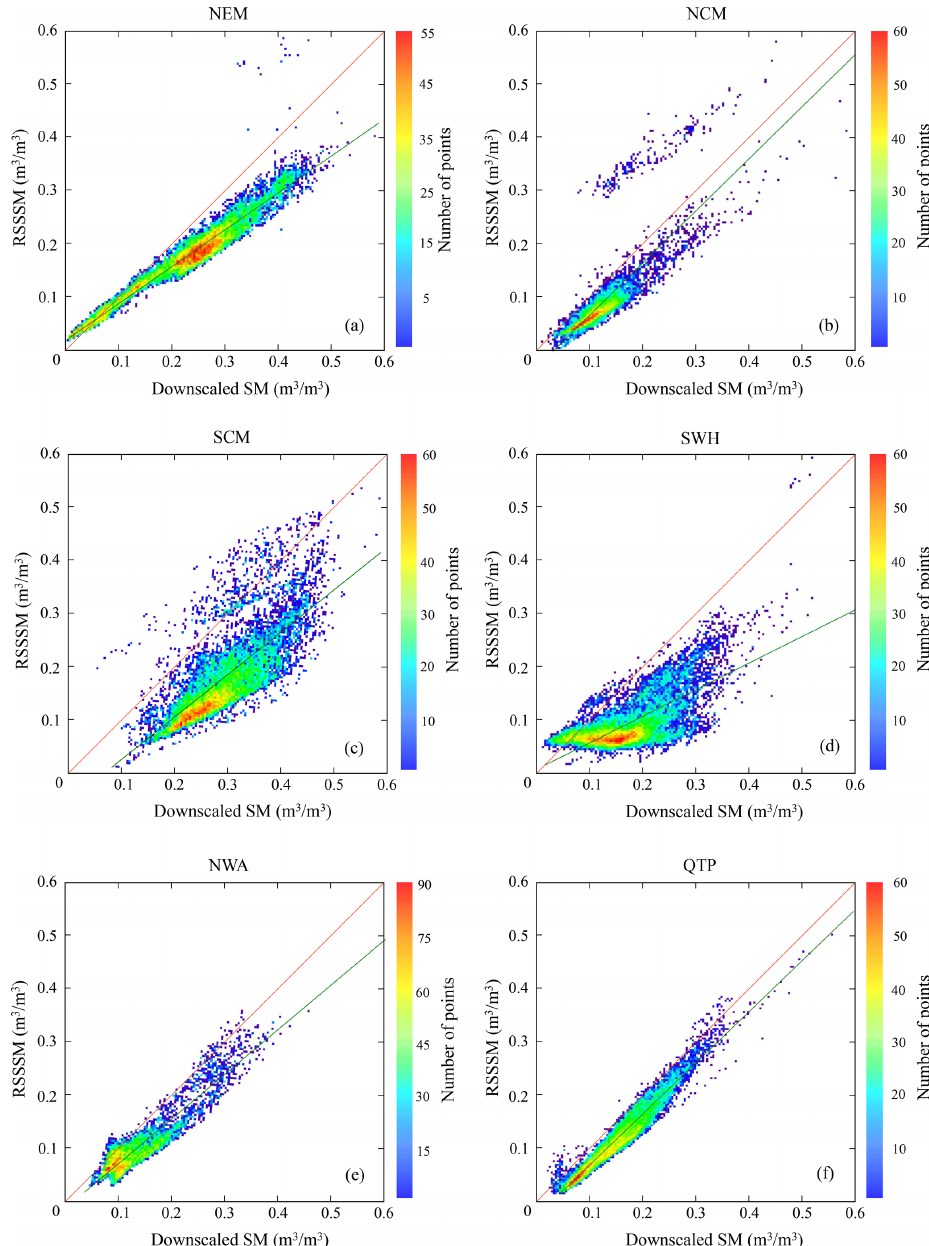
Figure B1. Scatterplot sand fitting of the RSSSM and downscaled SM dataset in six